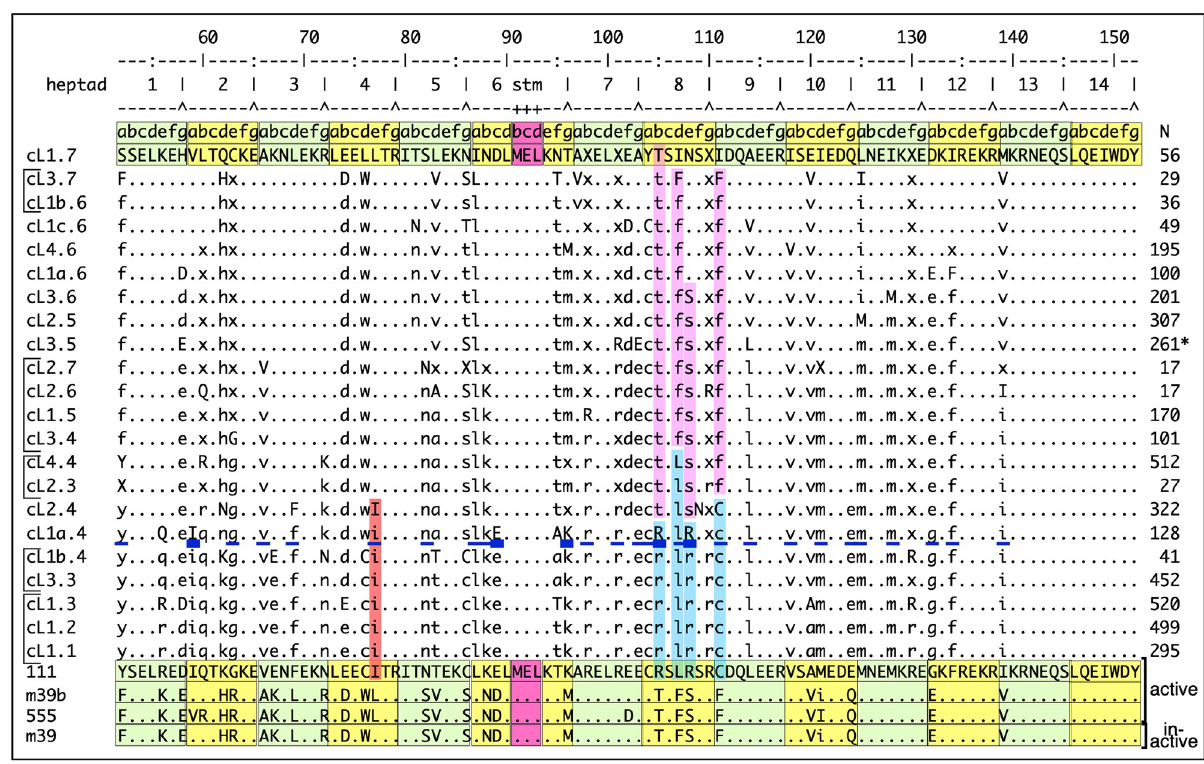
Fig 5. Coiled coil amino acid changes. The 50% consensus sequence of cL1.7, is at the top of the alignment and those of the other clusters given below, arranged according to their position on the phylogenetic tree (Fig 4), with the ones sharing the same node bracketed. The number of sequences in each cluster is given in the right-hand column. Dots indicate amino acid identity, and letters indicate differences, capitalized upon their first appearance. The thin and heavy underlined positions of the cL1a.4 consensus indicate respectively the modern (111) residues that had already arisen in the coiled coil or first appeared here. The pink and blue columns highlight the emergence and replacement of the residues in heptads 8 and 9 that are negatively epistatic in the modern coiled coil (Fig 1). The red box shows the emergence of I77, which is negatively epistatic in the ancestral context. The sequences of 111 with its differences from the active 555 and m39b variants and the inactive m39 variant are at the bottom of the alignment. S5 Fig shows the CG-less (_o) and CG-restored (rt) translation products of the coiled coil clusters consensus sequences. S6 Fig shows a LOGO plot of the CG-restored translation products, and S7–S11 Figs show various alignments of the coiled coil sequences that populate the cL1.3 (L1Pa3), L1Pa2 (cL1.2) and L1Pa1 (cL1.1) clusters (see